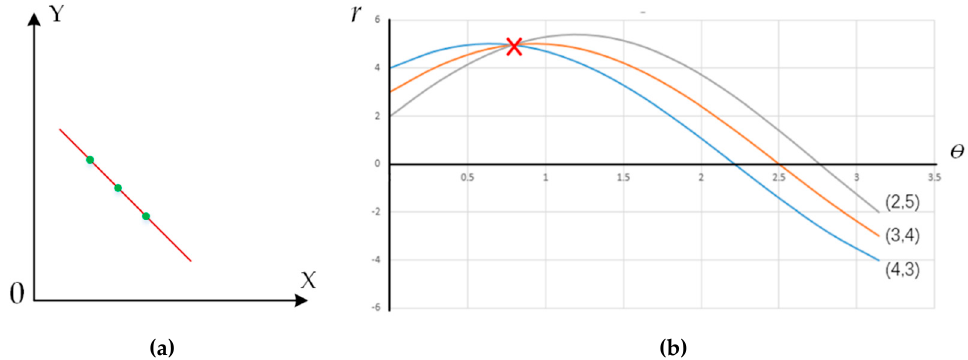
Figure 5. An instance of points in a 2D space being transformed into sinusoids in Hough space: ( a ) three points in 2D space and ( b ) three sinusoids in Hough space.